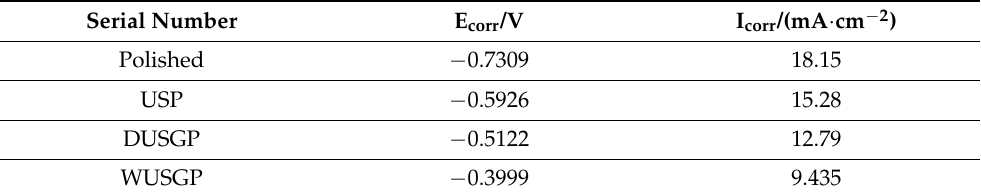
Figure 4. The polarization curves of all the samples. Table 3. Corrosion potential (E corr ) and the corrosion current density (I corr ) obtained in electrochemical corrosion test for each sample.